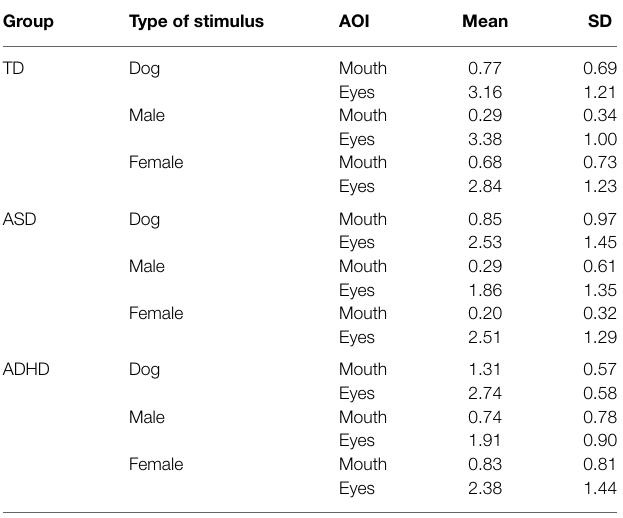
TABLE 1 | Descriptive statistics for total fixation time as a function of group, type of stimulus, and AOI . Group